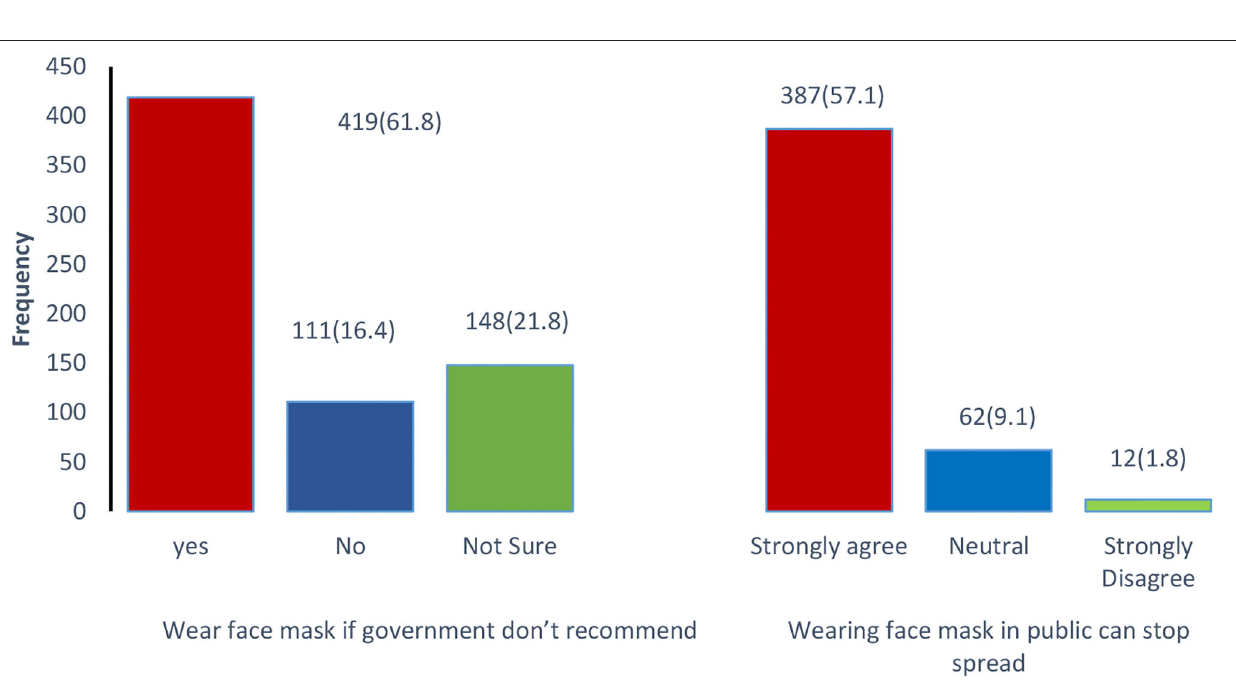
FIGURE 1 | Participant’s knowledge of wearing the face mask.